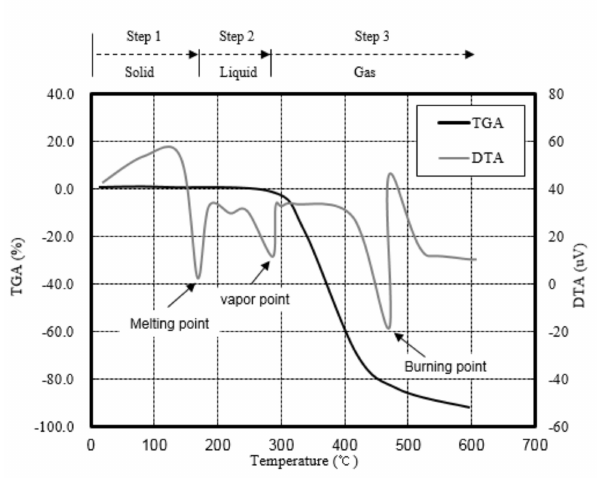
Figure 2. TGA (The rmogravimetric analysis) and DTA (Di ff erential thermal analysis) profiles for various fibers, including the melting point, vapor point, and burning